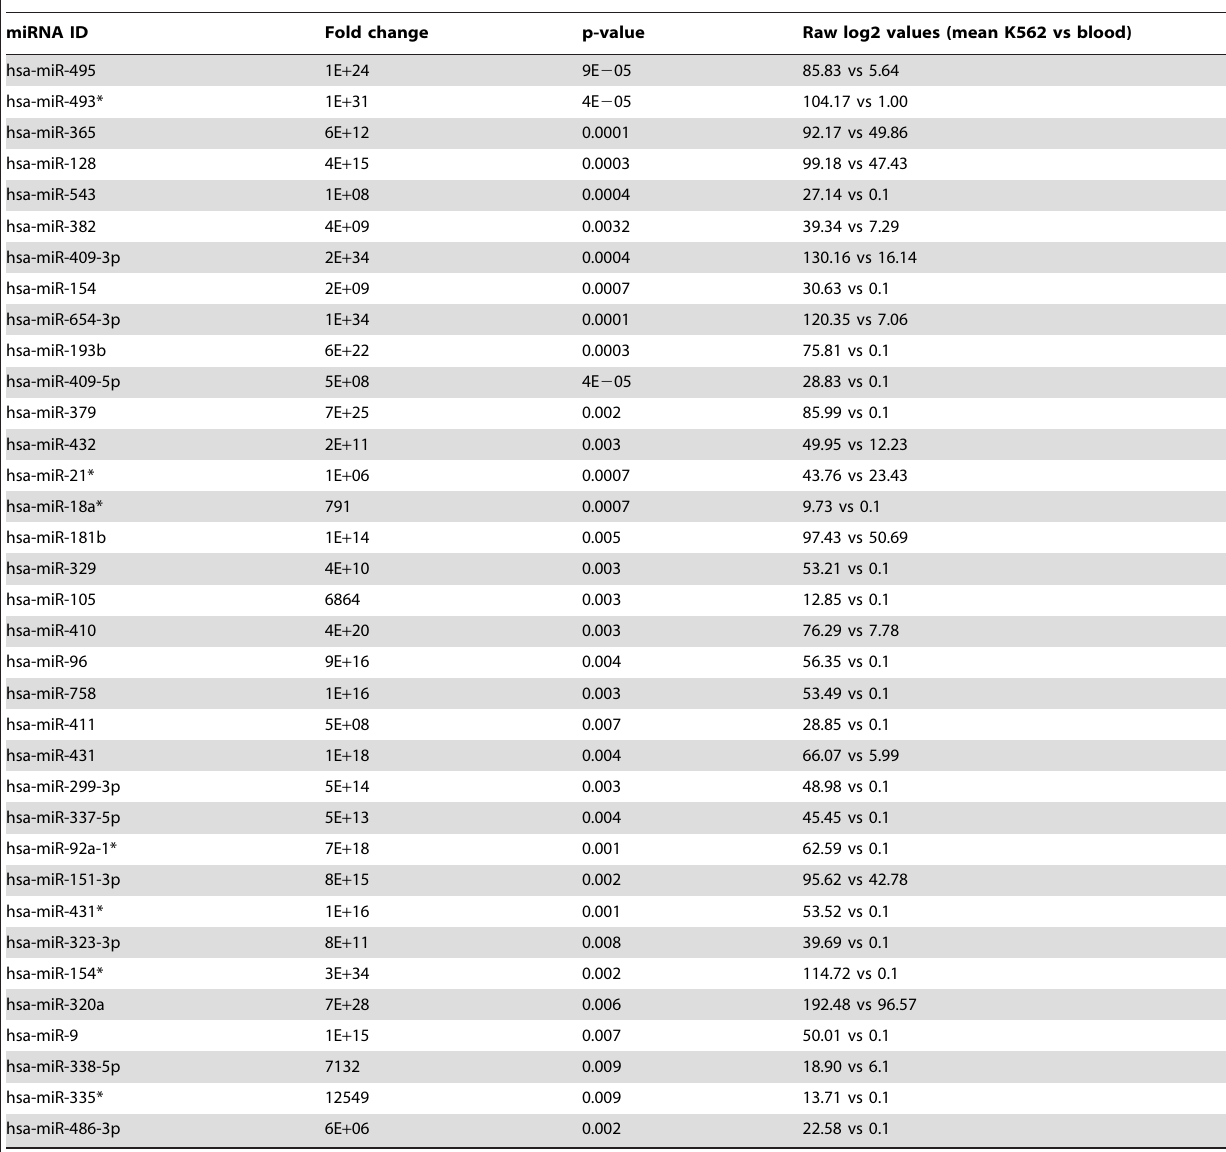
Table 2. Summary of miRNAs upregulated in K562 cells as compared to healthy blood